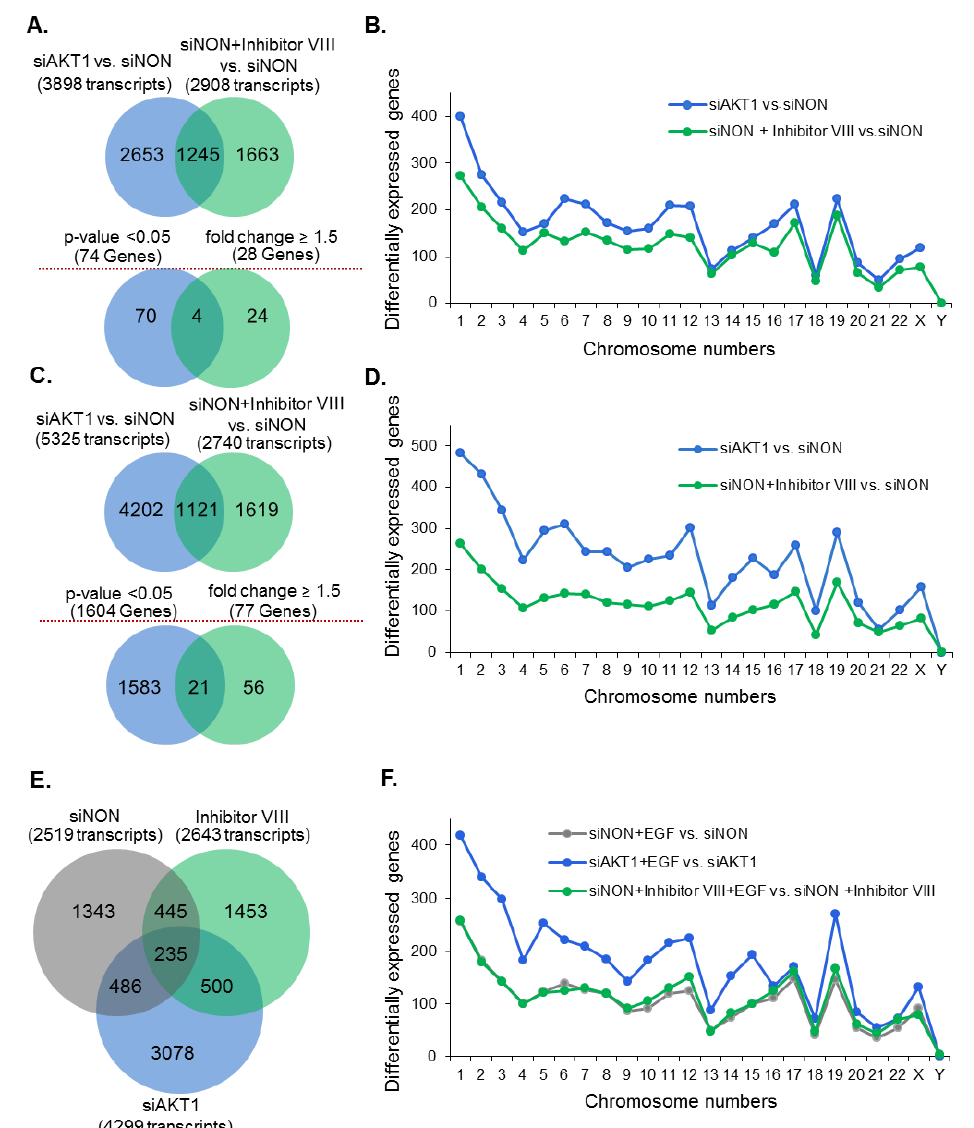
Figure 2. Effect of AKT1 on the status of differentially expressed genes in breast cancer cells. ( A ) Venn diagram showing the shared and uniquely expressed differentially expressed genes upon depletion of AKT1 or treatment with AKT inhibitor VIII as compared to cells treated with siNON. The total number of differentially expressed transcripts with 2-fold change are represented in parentheses. Results of comparative analysis of statistically significant ( p -value < 0.05 and fold change > 1.5) differentially expressed genes are shown in the lower panels; ( B ) ≥ chromosome-wise distribution of differentially expressed transcripts corresponding to the preceding upper panel A; ( C ) Venn diagram showing the comparison of the number of differentially expressed transcripts with 2-fold change in EGF-stimulated breast cancer cells. Results of comparative analysis of statistically significant ( p -value < 0.05 and fold change > 1.5) differentially expressed genes are shown in the lower panels; ( D ) chromosome-wise distribution of transcripts corresponding to genes in upper panel C; ( E ) genes altered (>2-fold change) in the indicated experimental conditions in EGF-stimulated breast cancer cells; and ( F ) chromosome-wise distribution of differentially expressed genes in EGF-stimulated breast cancer cells in Panel E.